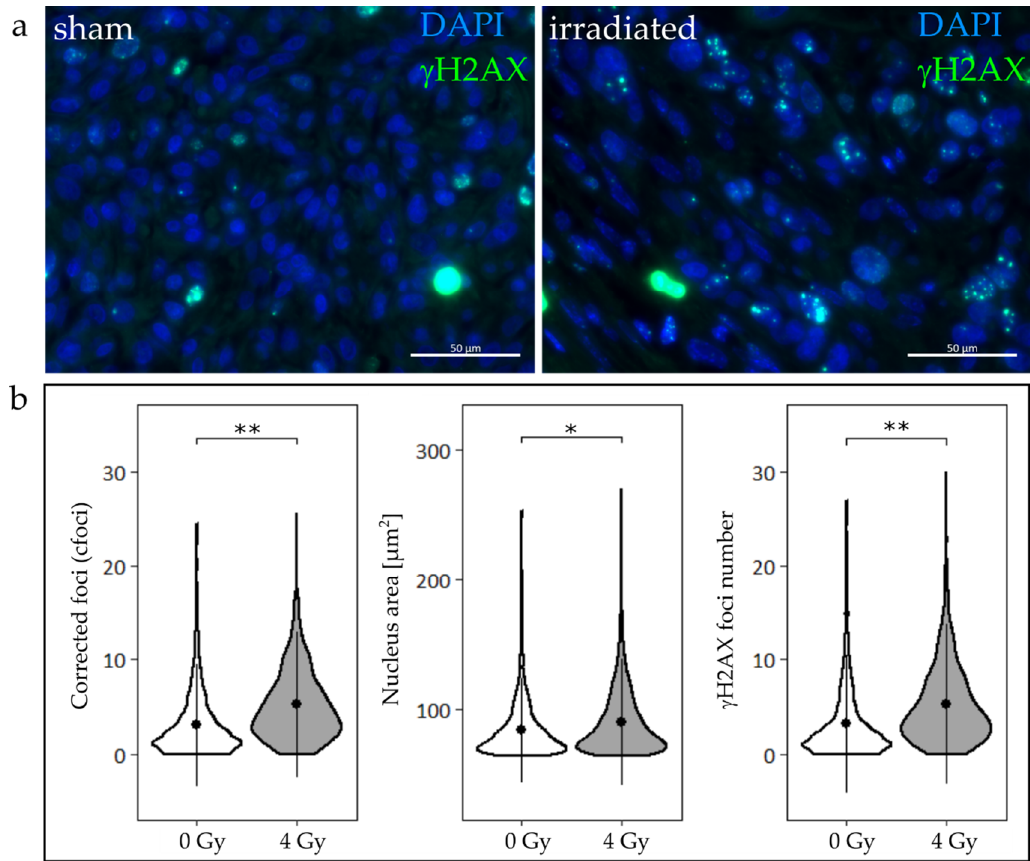
Figure 5. Formation of γH2AX foci in tumor slices exposed to sham (0 Gy) or 4 Gy proton irradiation at 24 h post irradiation. ( a ) Representative immunofluorescent images of tumor slices treated with sham ( left ) or proton irradiation ( right ) show γH2AX foci. Apoptotic cells and endogenous DNA damages were observed in both groups; nevertheless, an increased number of foci could be detected in irradiated slices. ( b ) cfoci, nucleus area, and γH2AX foci numbers are significantly increased in slices that were irradiated with 4 Gy, compared to non-irradiated controls (linear mixed-effects model, *: p < 0.05, **: p < 0.01; n Control = 7, n Tumor = 8) .